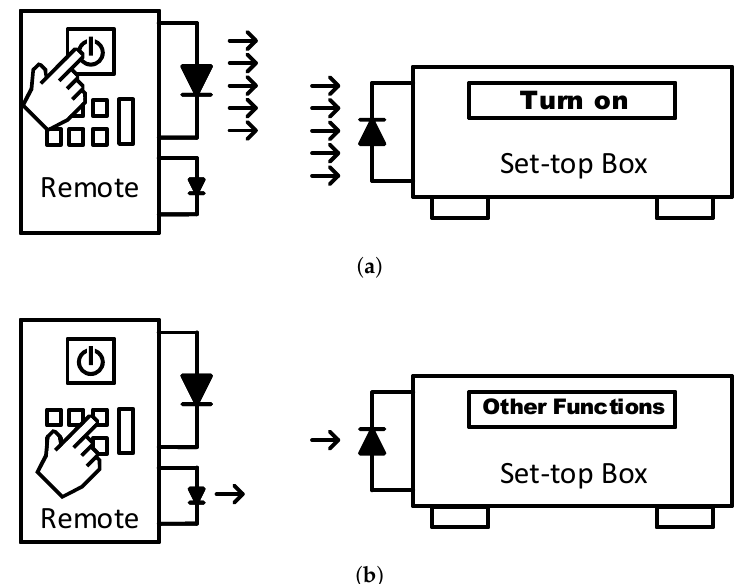
Figure 2. Infrared (IR)-based zero standby solution proposed in Reference [7,8]. ( a ) A high-power IR signal is transmitted to wake the device. ( b ) Once the device is awake, ordinary low-power IR signals can be used for all other functions (e.g., changing the